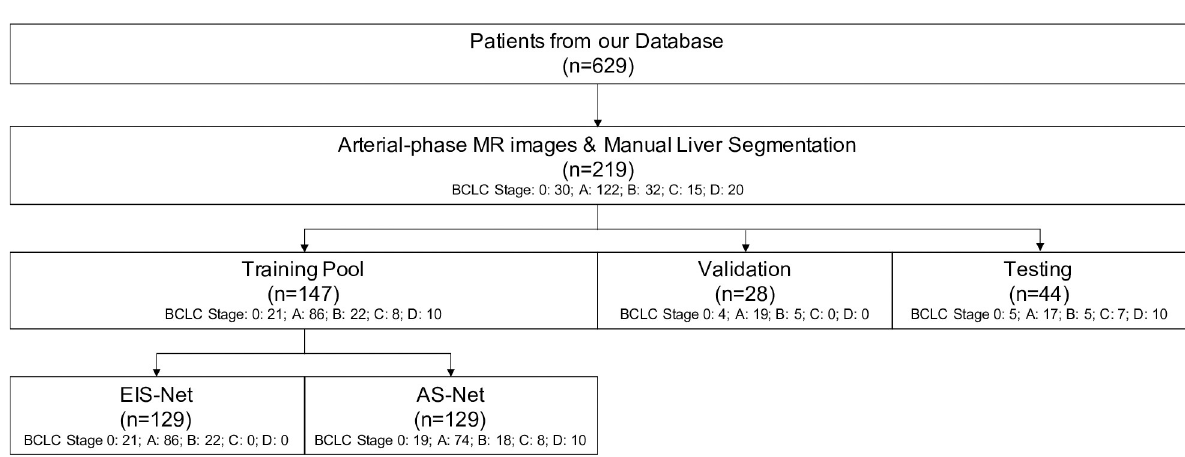
Fig 2. Inclusion and exclusion criteria, and partitioning of the dataset for model training and evaluation. From an institutional database, 219 HCC patients that had arterial-phase MR images and a manual liver segmentation available for processing were included. Subjects from each BCLC stage were then allocated to the test set and patients were selected for shared validation and testing sets. From the overall training pool, subjects were sampled to create two training data subsets for the Early-Intermediate-Stage-Net (EIS-Net) and the All-Stage-Net (AS-Net).